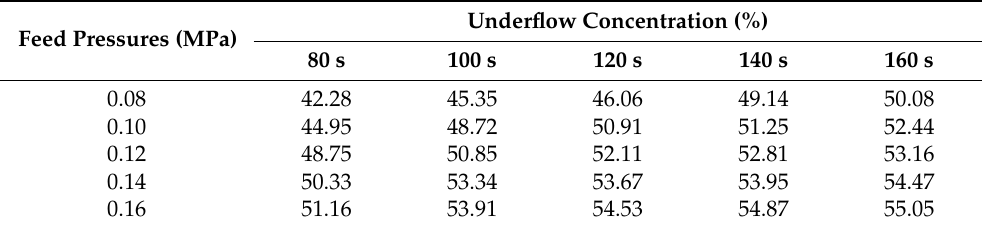
Table 9. Changes in the underflow concentration under different feed